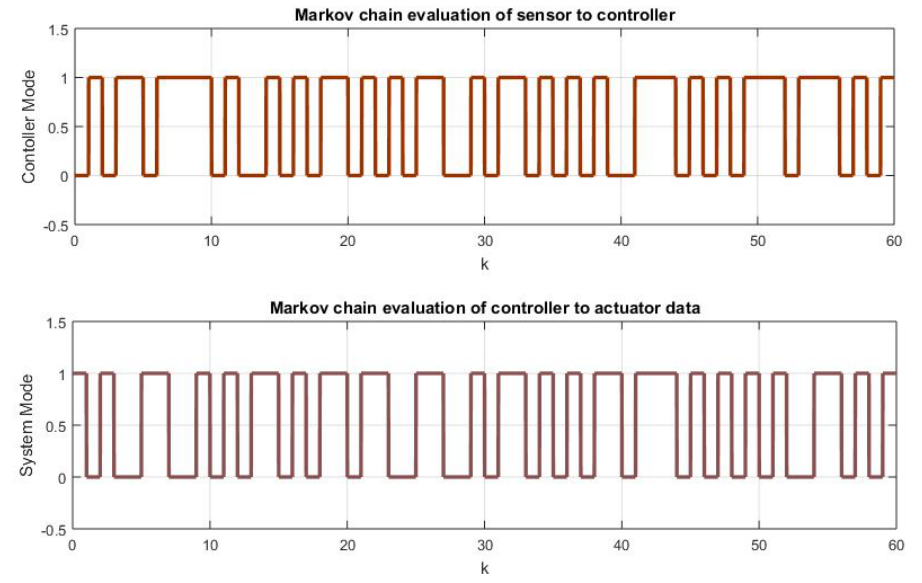
Figure 5. Evolution of Markov